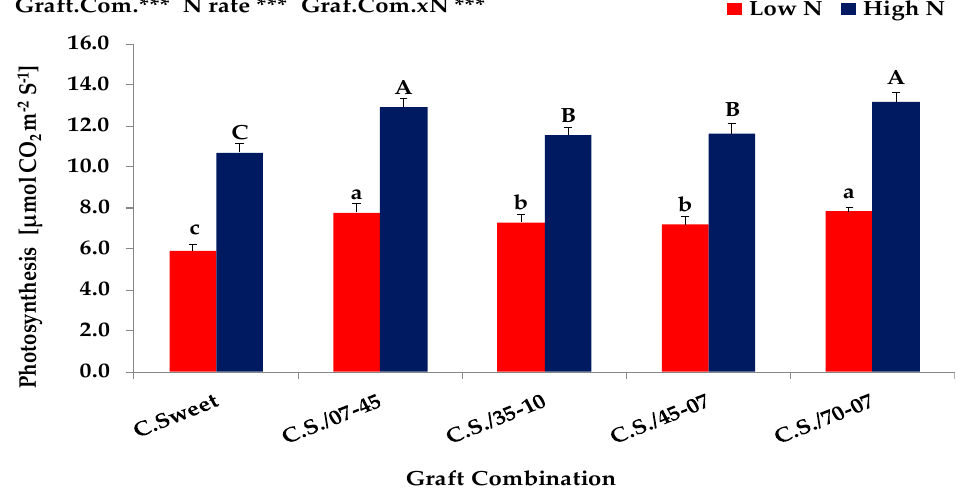
Figure 3. Photosynthesis of non-grafted and grafted watermelon cultivar (Crimson Sweet) onto four bottle gourd genotypes grown under low (0.3 mM) and high (3.0 mM) N supply in Expt. 2 . Values denoted by different letters (lower- and upper-case letters for low and high N supply, respectively) are significantly different between genotypes within columns at p < 0.05. ns, non-significant. * p < 0.05, ** p < 0.01 and *** p < 0.001.